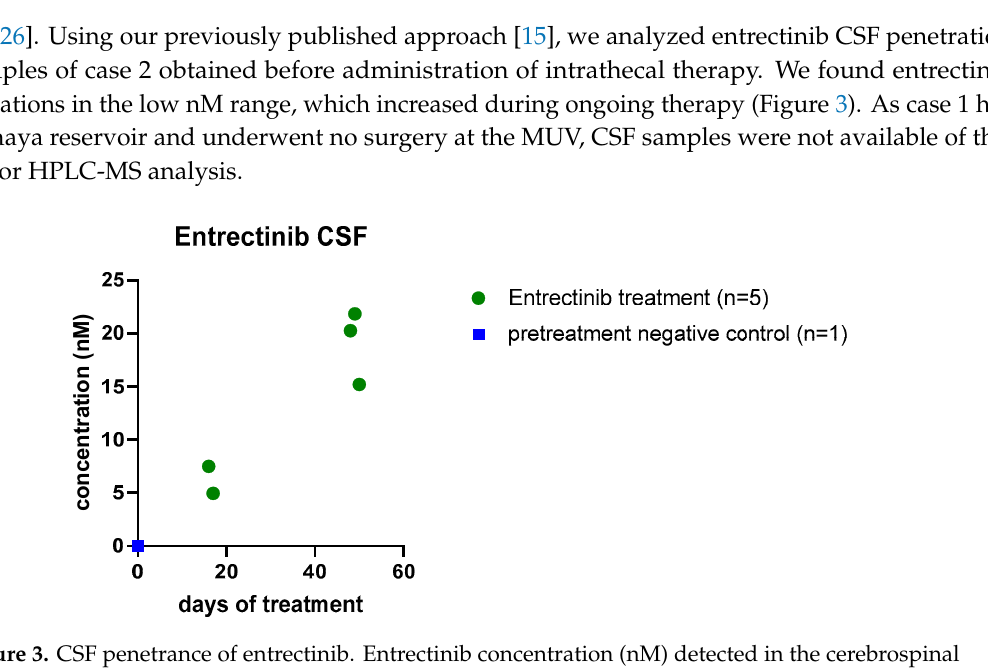
Figure 3. CSF penetrance of entrectinib. Entrectinib concentration (nM) detected in the cerebrospinal fluid of case 2 by high-performance liquid chromatography-mass spectrometry (HPLC-MS) as previously described [15]. Entrectinib levels increase over time of intake. Individual points depict entrectinib concentrations in independent samples obtained via an Ommaya reservoir before administration of intrathecal therapy.